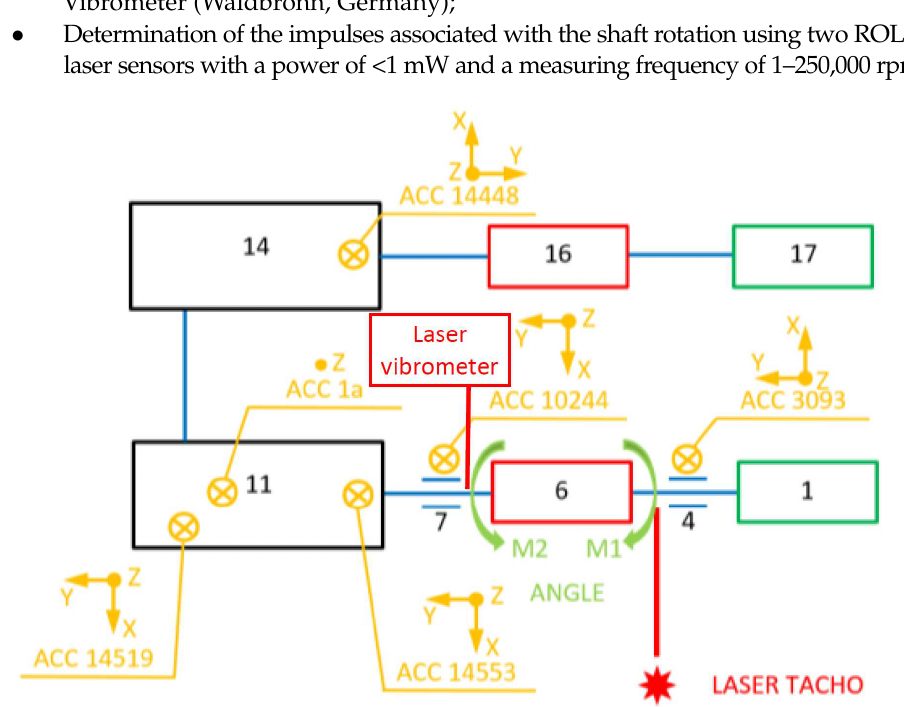
Figure 7. Arrangement of measurement points; designations: 1—driving motor, 4,